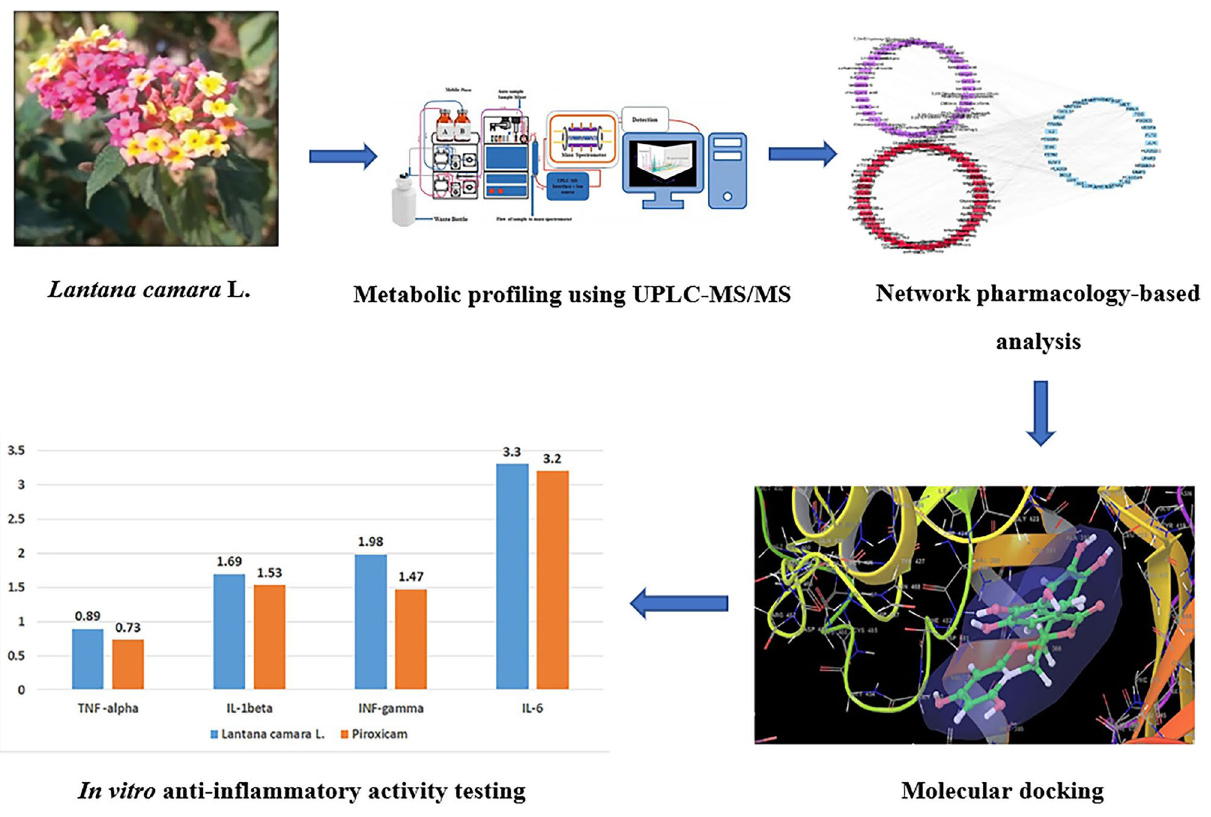
Figure 1. Study workflow